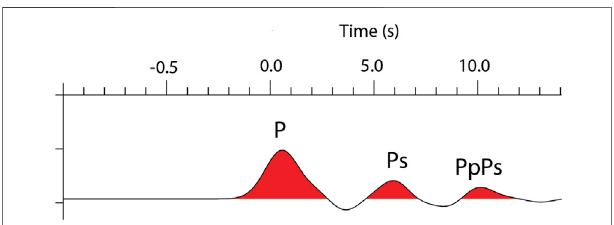
FIGURE 3 | This is a sampled receiver function (RF), which is calculated from the deconvolution of the horizontal from the vertical component. The deconvolution is processed from the data collected by the ASSE station from an earthquake coming from a ~178 ° azimuth. The diagram shows the direct P and the converted Ps and the PpPs